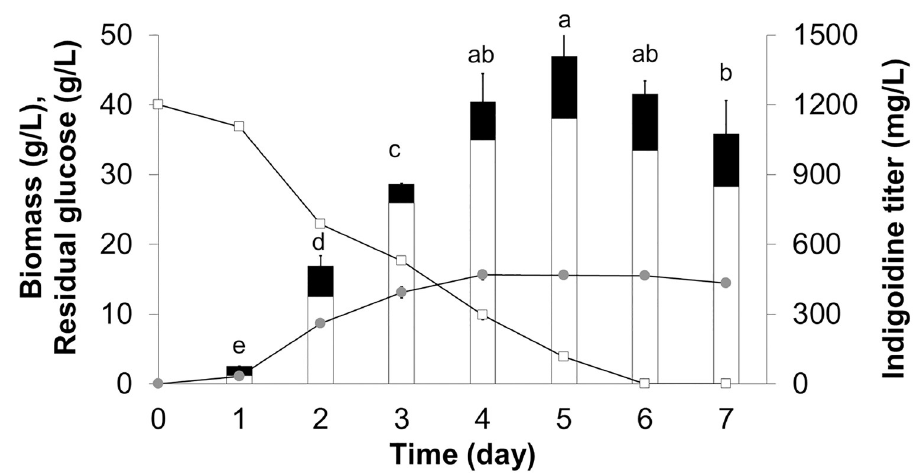
Fig 4. Cellular growth and extracellular InK production profiles of AoInK cultures treated with Tween 80. Fungal cultures were grown in SM medium supplemented with 2 mM glutamine and 1% Tween 80 at 25˚C, 200 rpm. The samples were taken at different cultivation times for analyses. Dry biomass (gray circle), residual glucose concentration (white square), and intracellular and extracellular InK titers (white and black bars, respectively) are shown. Letters above the bars indicate significant differences in total InK titer ( p <